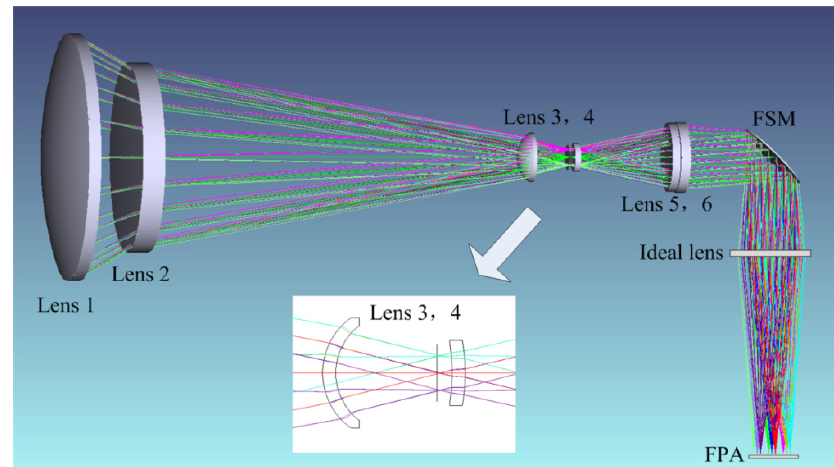
Figure 5. Optical system according to the field mapping conditions h x = f (cid:48) ϑ x , h y = f (cid:48) θ